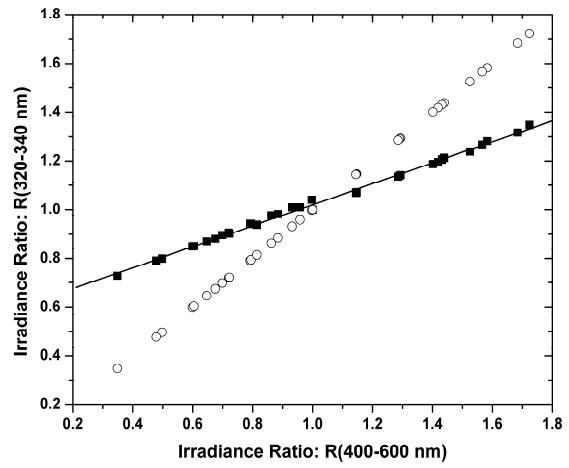
Fig. 11. Computed irradiance ratios for 320–340nm plotted against those for 400–600nm, showing the wavelength dependence in the attenuation or enhancement in solar irradiance associated with clouds as produced by theory. Open circles define the case of no wavelength dependence. The solid line is a fit to radiative transfer calculations indicated by squares.